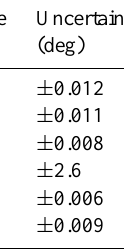
Fig. 6. Evolution of the local elevation deviations with respect to the azimuthal angle. The upper points (diamonds) correspond to Position 1 of the antenna, the lower points (triangle) to Position 2. The error bars figure the 99% confidence interval. The solid lines indicate the fitted models from Eq.8.